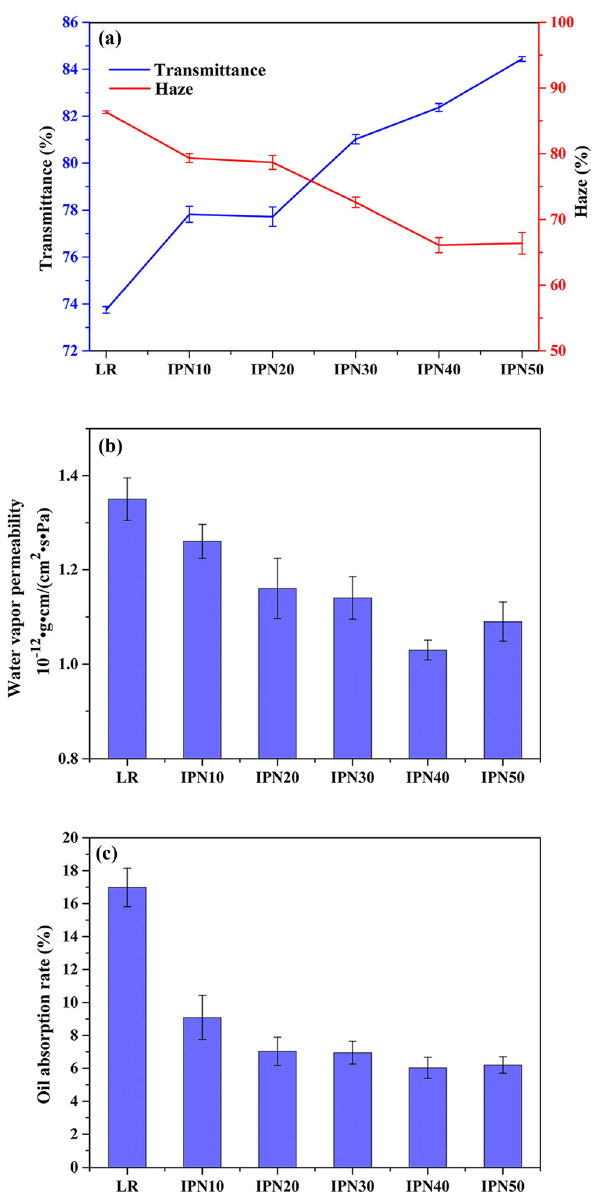
Figure 6: Visible light transmittance and haze ( a ) , WVP ( b ) , and oil absorption ( c ) of LR and IPN fi lms.